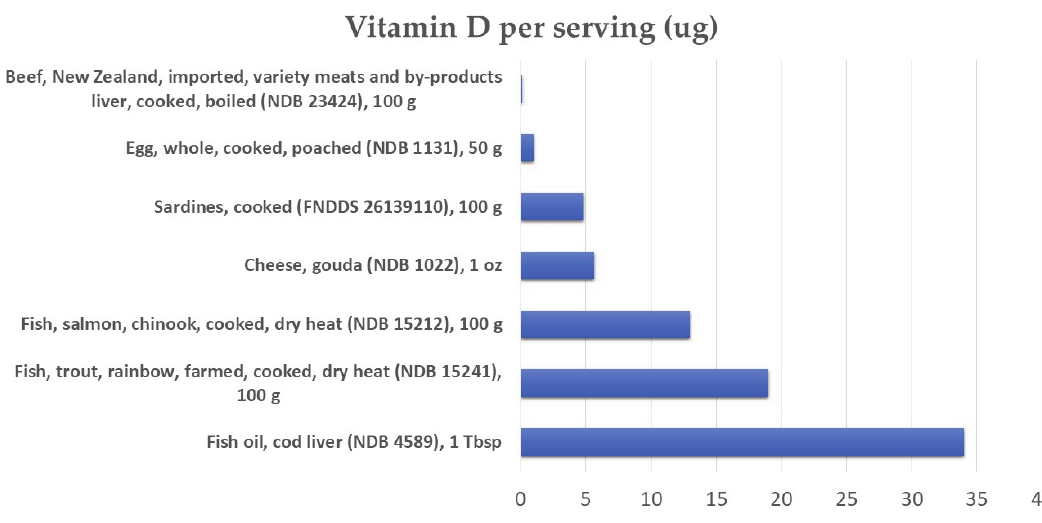
Figure 1. Main dietary sources of vitamin D. NDB: Nutrient Database number corresponding to USDA food database coding: https://fdc.nal.usda.gov (accessed on 27 October 2022).